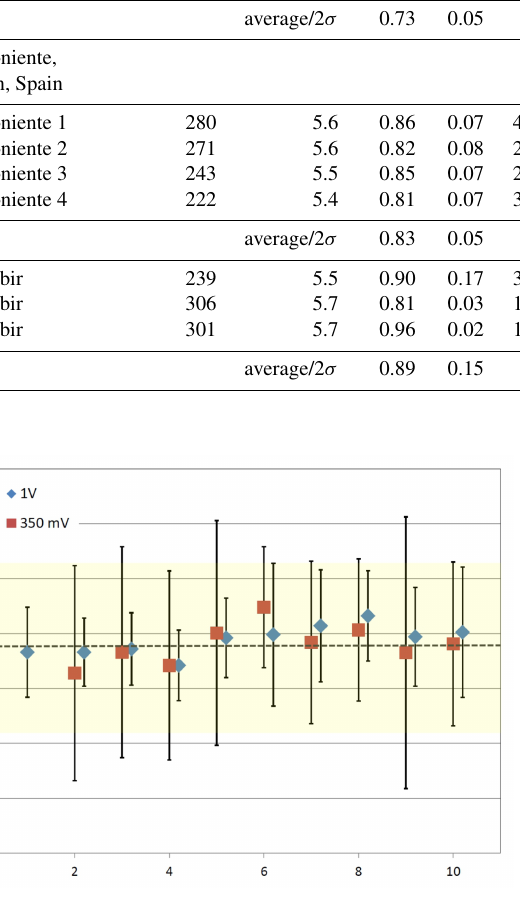
Figure 3. Plot depicting average δ 53 Cr values from multiple fila- ment runs with 200 nanogram loads of NIST SRM 979 measured on the PHOENIX thermal ionization mass spectrometer at 53 Cr beam intensities of 350mV and 1V, respectively. The yellow col- ored range indicates the ± 0 . 08‰ external reproducibility of the 10 filaments loads ran at 350mV 53 Cr beam intensities, which cor- respond to typical beam intensities obtained from our